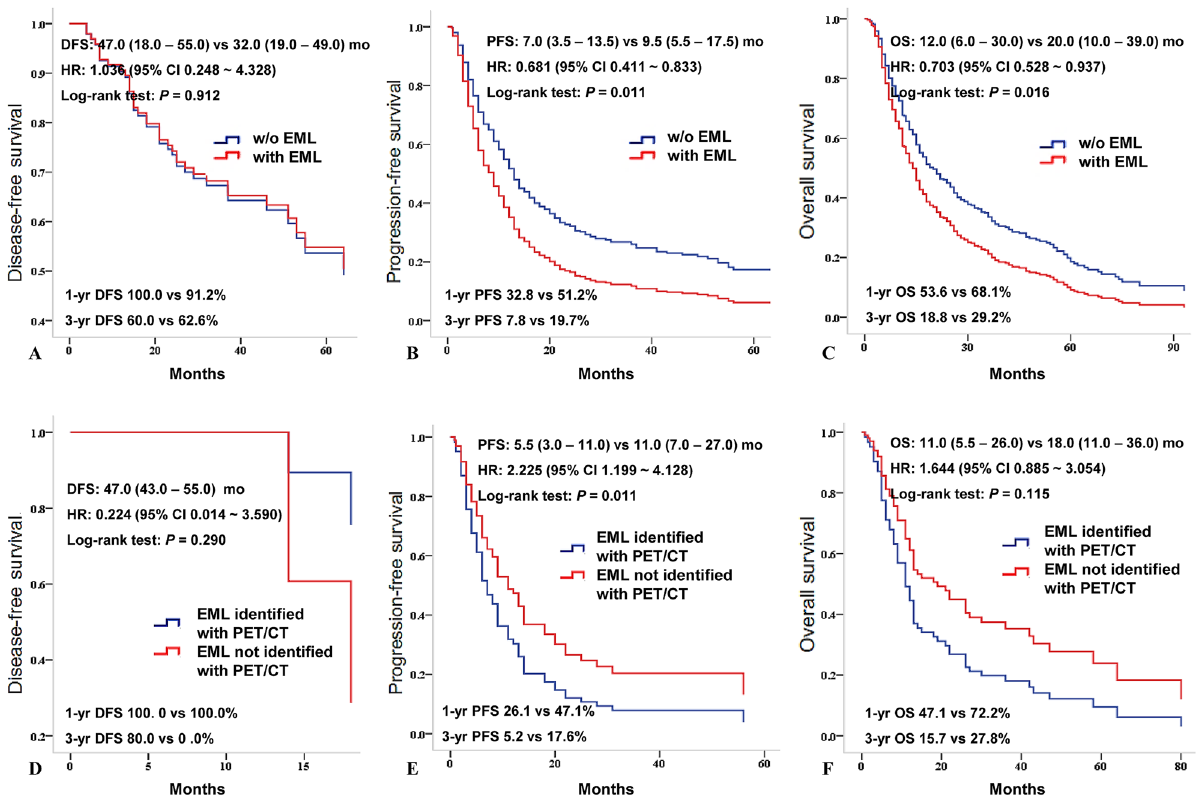
Figure 2. Median DFS, PFS and OS between NSCLC patients with and without EML other than primary cancer (N = 364) Median DFS was 47.0 (18.0–55.0) and 32.0 (19.0–49.0) months and in patients with EML compared to patients without EML (HR = 1.036, 95% CI 0.248–4.328, P = 0.912, ( A ); Median PFS (7.0 (3.5–13.5) vs. 9.5 (5.5–17.4) mo, HR = 0.681, 95% CI 0.411–0.833, P = 0.011, ( B) and OS (12.0 (6.0–30.0) vs. 20.0 (10.0– 39.0) mo, HR = 0.703, 95% CI 0.528–0.937, P = 0.016, ( C) were significantly lower in patients with EML other than primary cancer. Median DFS ( D ), PFS ( E ) and OS ( F ) between NSCLC patients who have EML identified and not identified on PET/CT (N = 69). Median DFS 47.0 (43.0–55.0) mo vs. not checkable (HR = 0.224, 95% CI 0.014–3.590, P = 0.290, ( D ); Median PFS (5.5 (3.0–11.0) vs. 11.0 (7.0–27.0) mo, HR = 2.225, 95% CI 1.199–4.128, P = 0.011, ( E ); and OS 11.0 (5.5–26.0) vs. 18.0 (11.0–36.0) mo, HR = 1.644, 95% CI 0.885–3.054, P = 0.115, ( F ) between two groups. PFS was significantly higher in patients with EML not identified with PET/CT. DFS disease-free survival, EML endobronchial metastatic lesion, HR hazard ratio, mo months, NSCLC non-small cell lung cancer, OS overall survival rate, PFS progression-free survival rate, vs.